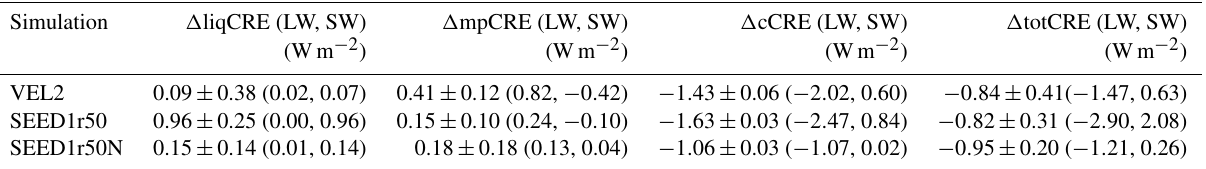
Table 5. Top-of-the-atmosphere net cloud radiative effect anomalies of cirrus geoengineering with the individual contributions from cirrus clouds (cCRE, for temperatures < − 35 ◦ C), mixed-phase clouds (mpCRE, − 35 ◦ C < T < 0 ◦ C), and liquid clouds (liqCRE, T > 0 ◦ C) for the VEL2, SEED1r50, and SEED1r50N fixed SST simulations. The radiative anomalies are further divided into their LW and SW components (shown in